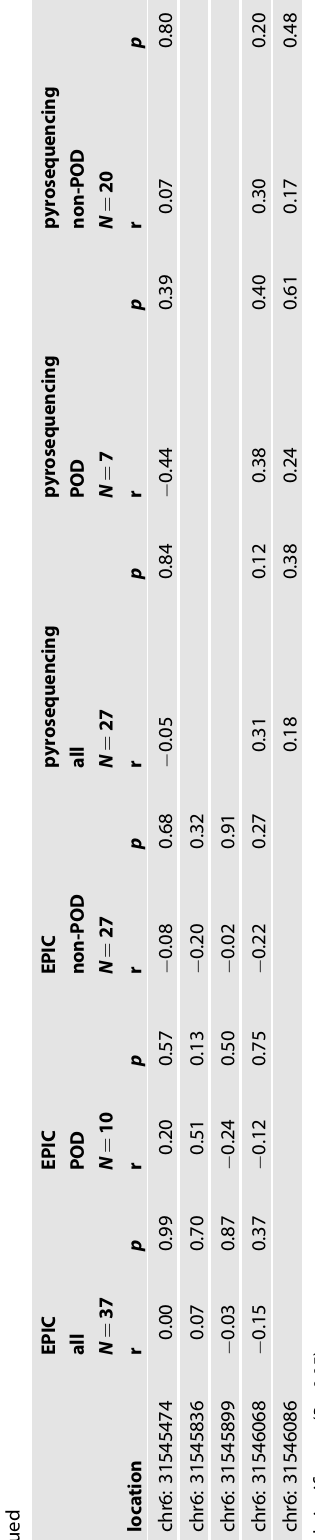
leading to neuroin fl ammation, and thus increased risk of delirium [10, 25]. When focusing on each CpG site, there was no signi fi cant difference between the POD group and the non-POD group in terms of preoperative DNAm level, postoperative DNAm level, or degree of change by neurosurgery. This might be partly due to the limited sample size. However, in the POD group, we observed at multiple CpG sites that the DNAm level, which varied before surgery, accumulated to a certain narrow range after surgery (Supplementary Fig. 1). Furthermore, it was suggested that scoring of these multiple CpG sites by DNAm level of postoperative blood (IMI) may be useful for the diagnosis of POD (Fig. 1A). The detection ability by IMI was well validated by our independent data set (Fig. 1B). On the other hand, pre-IMI score and diff-IMI score, which were based on DNAm level of preoperative blood and amount of change in DNAm level after surgery, also showed high AUCs, although these methods were not validated as we did not have samples from independent cohorts to validate. Although there are numberless studies investigating delirium biomarkers, those results do not support the use of any one biomarker [26]. This might be because protein level and RNA expression can be T a